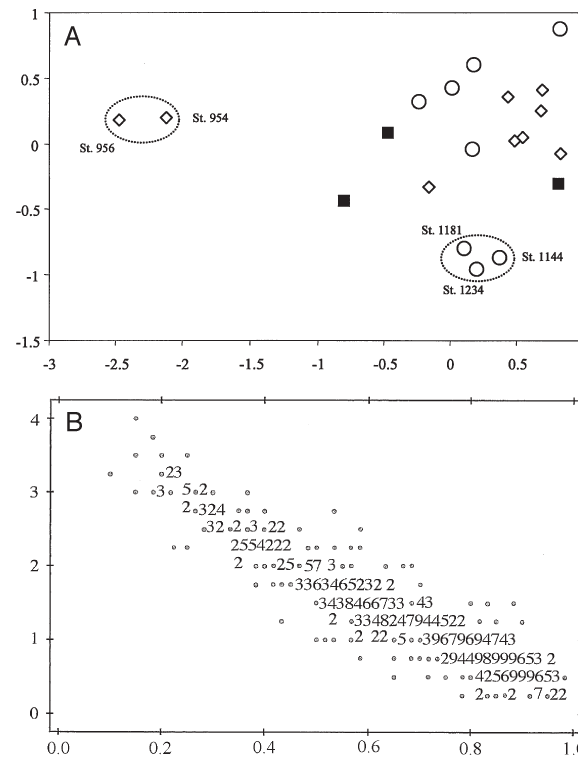
F IG . 6. – A, Ordination plot resulting from the similarity matrix using Cosine Similarity. Ordination is two-dimensional